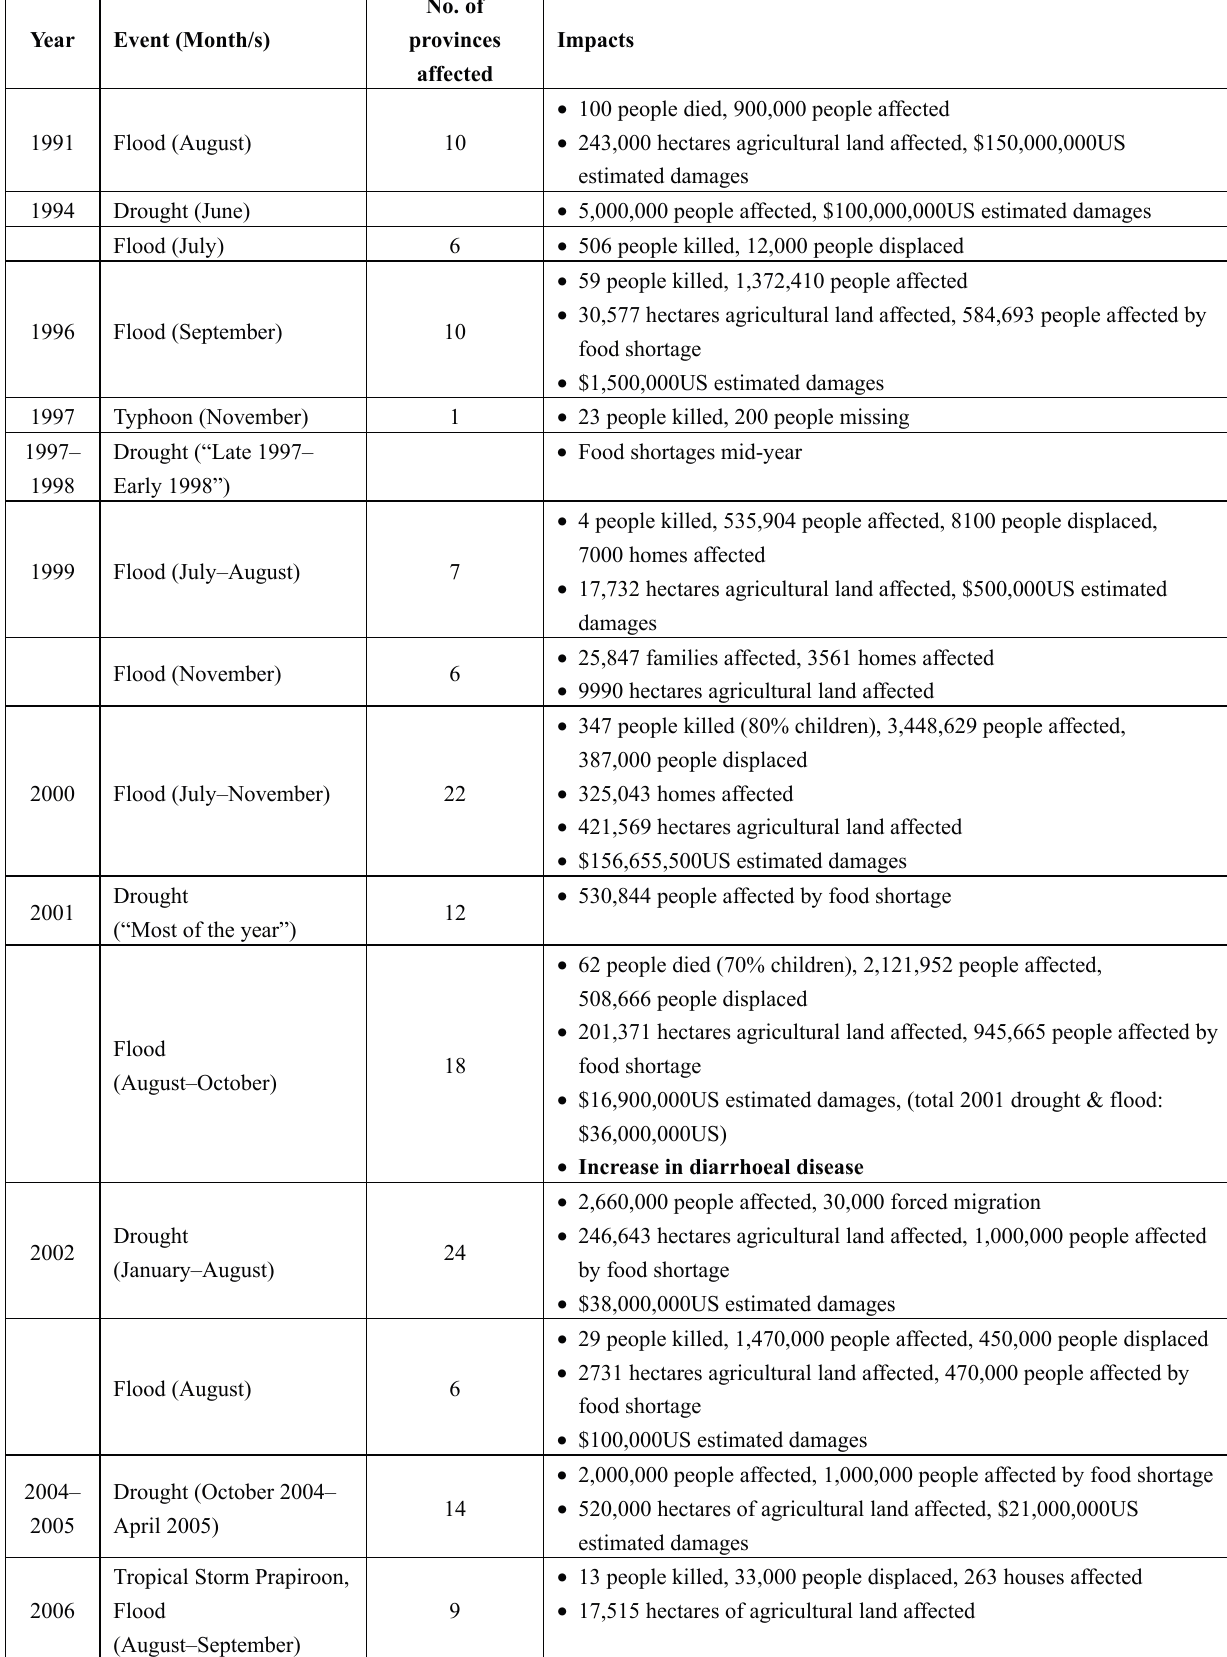
Table 1. A summary of the impacts of extreme weather events (floods, droughts and typhoons) in Cambodia from 1991–2013. Adapted from: